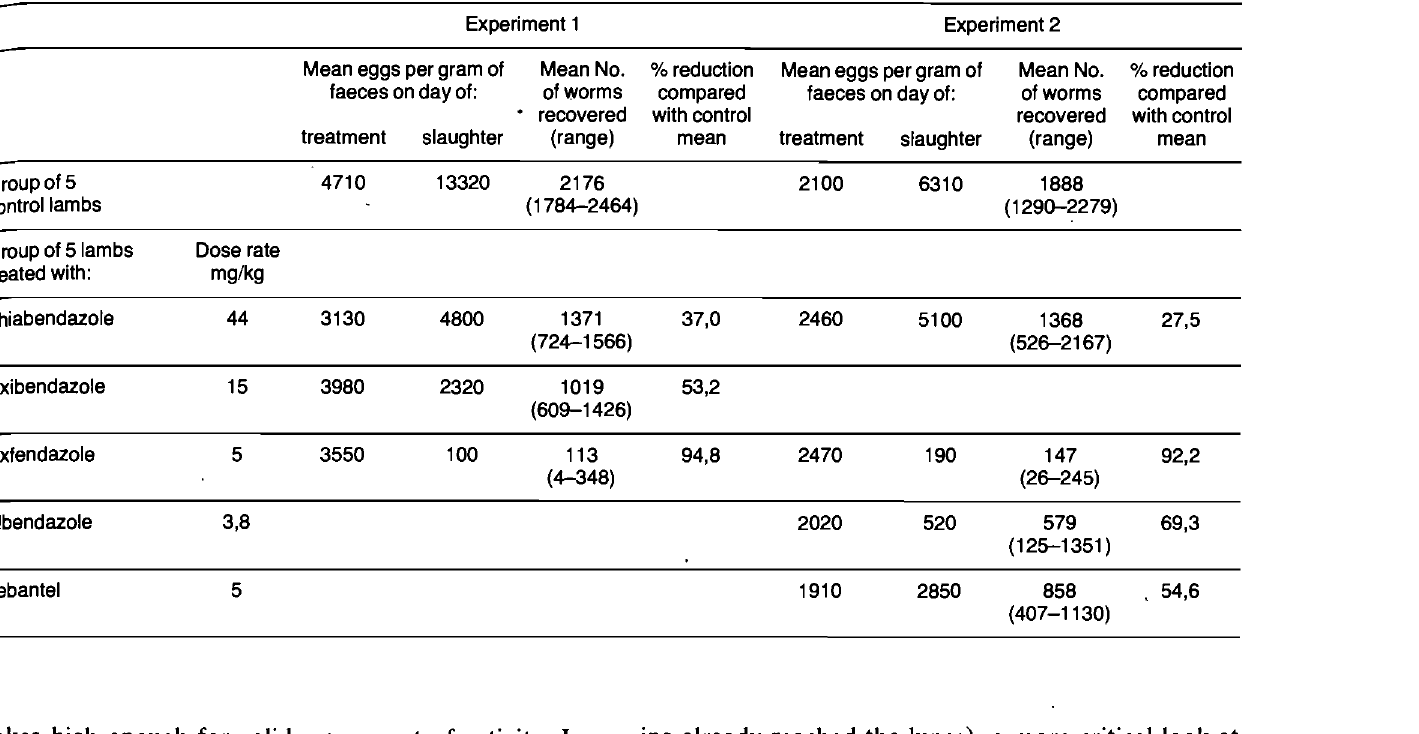
Table 4: COMPARATIVE BENZIMIDAZOLE TREATMENT OF LAMBS INFECTED WITH THE BOSHOF STRAIN OF H. Contortu5. FAECAL EGG COUNTS, WORM COUNTS AT NECR9pSY AND PERCENTAGE REDUCTIONS IN WORM